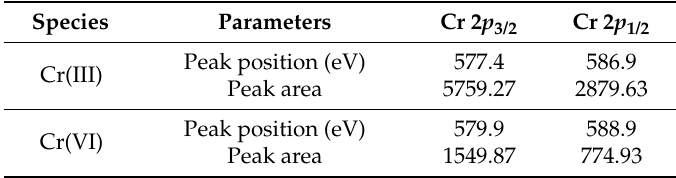
Figure 7. High-resolution XPS spectra of the 2 p 1/2 and 2 p 3/2 regions for Cr(VI)-containing WPAC. Table 4. Cr 2 p peak for WPAC before and after Cr(VI) adsorption at pH 3.